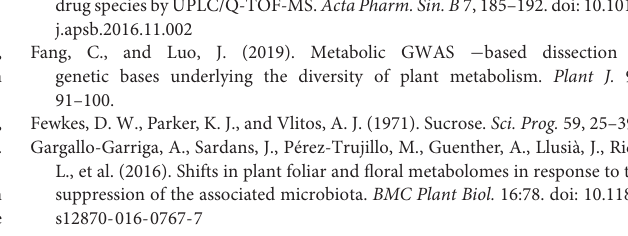
Supplementary Table 4 | Differences metabolites identified by MS/MS. Supplementary Figure 1 | Key constituents identified by MS/MS spectrometry. Supplementary Figure 2 | Z-score of differential